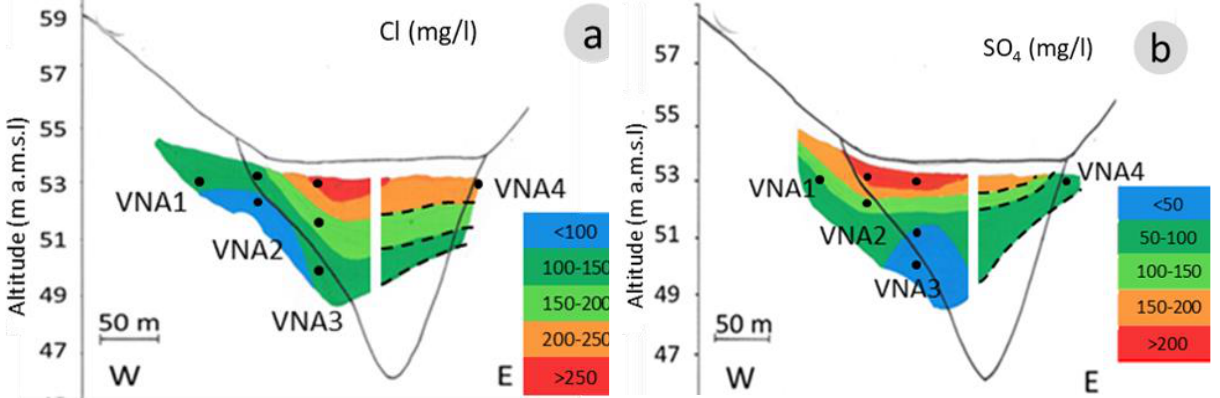
Figure 7. Distribution of the groundwater solute tracers along Transect A in Vasi-North: (a) chloride and (b) sulphate. Lines to the right of the white bar are interpolated, extending across the (unsampled) western side of the basin to the single sampling point at